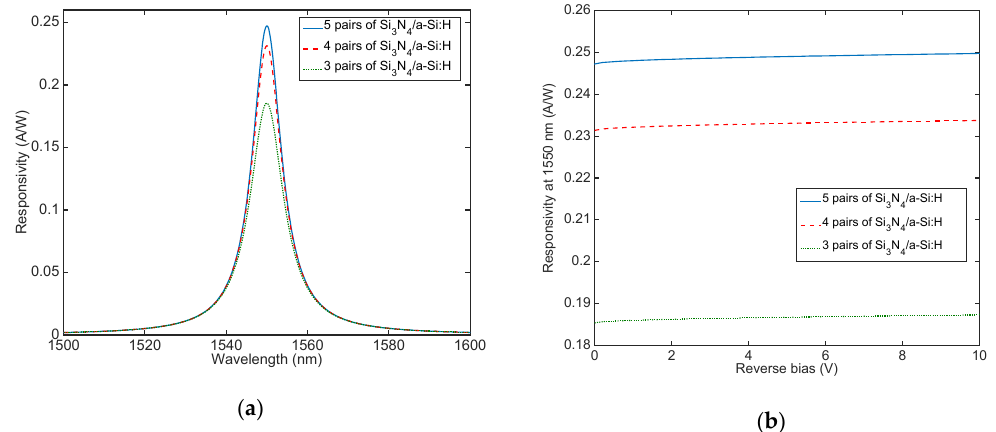
Figure 8. Responsivity ( a ) as function of the wavelength and ( b ) at 1550 nm as function of the reverse voltage applied for the TCC Fabry–Pérot graphene/Si Schottky PD.